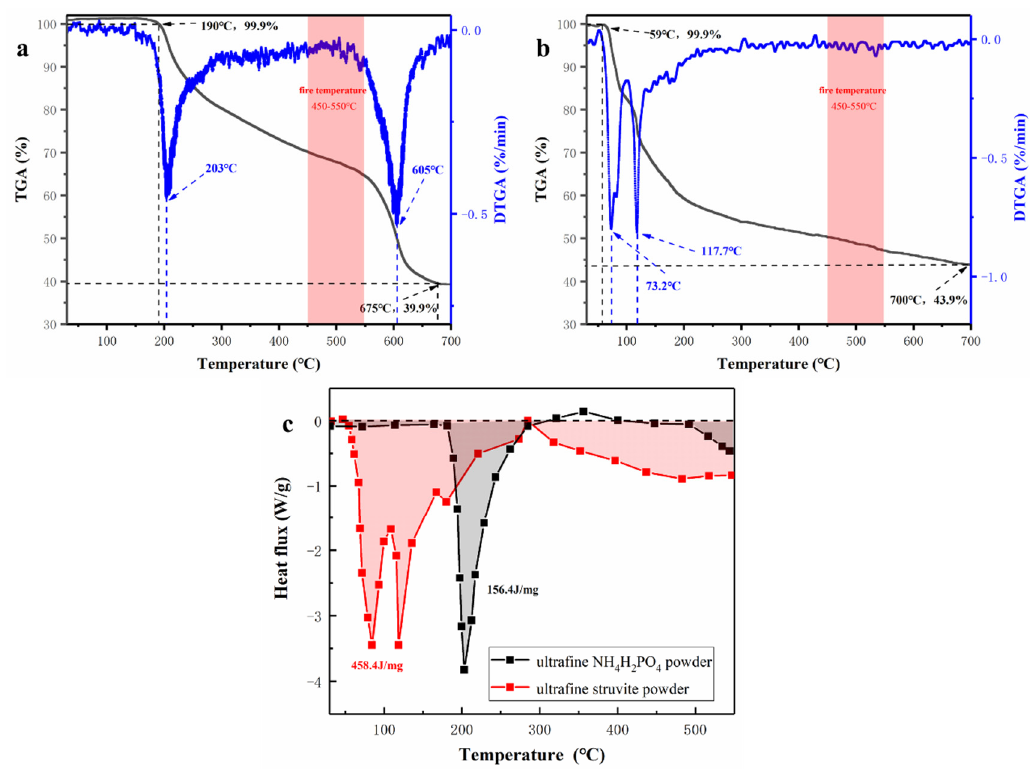
Figure 11. ( a ) Thermogravimetric (TG) and Derivative thermogravimetric (DTG) curves of NH 4 H 2 PO 4 , ( b ) Thermogravimetric (TG) and Derivative thermogravimetric (DTG) curves of struvite, ( c ) Differential scanning calorimetry (DSC) curves of sample